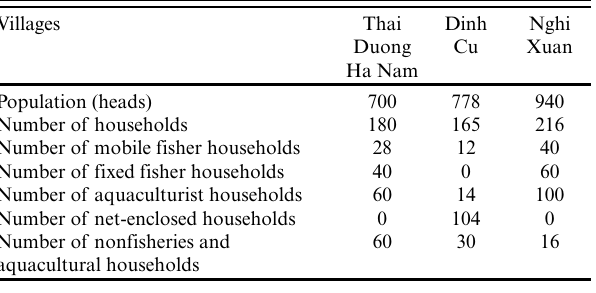
Table 1 . Demographics of the study sites, disaggregated per resource user group.